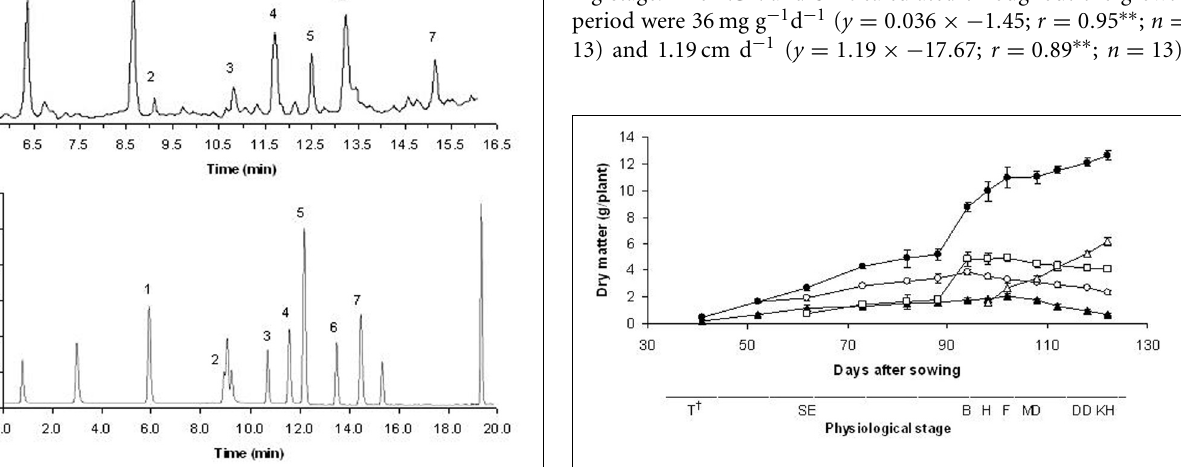
FIGURE 1 | Chromatographic profile of phenolic compounds in the rhizosphere soil of wild oat (A) and for standards (B). 1, 4-hydroxybenzoic acid; 2, vanillic acid; 3, syringic acid; 4, vanillin; 5, p -cumaric acid; 6, syringaldehyde; 7, ferulic acid; NI, not identified.